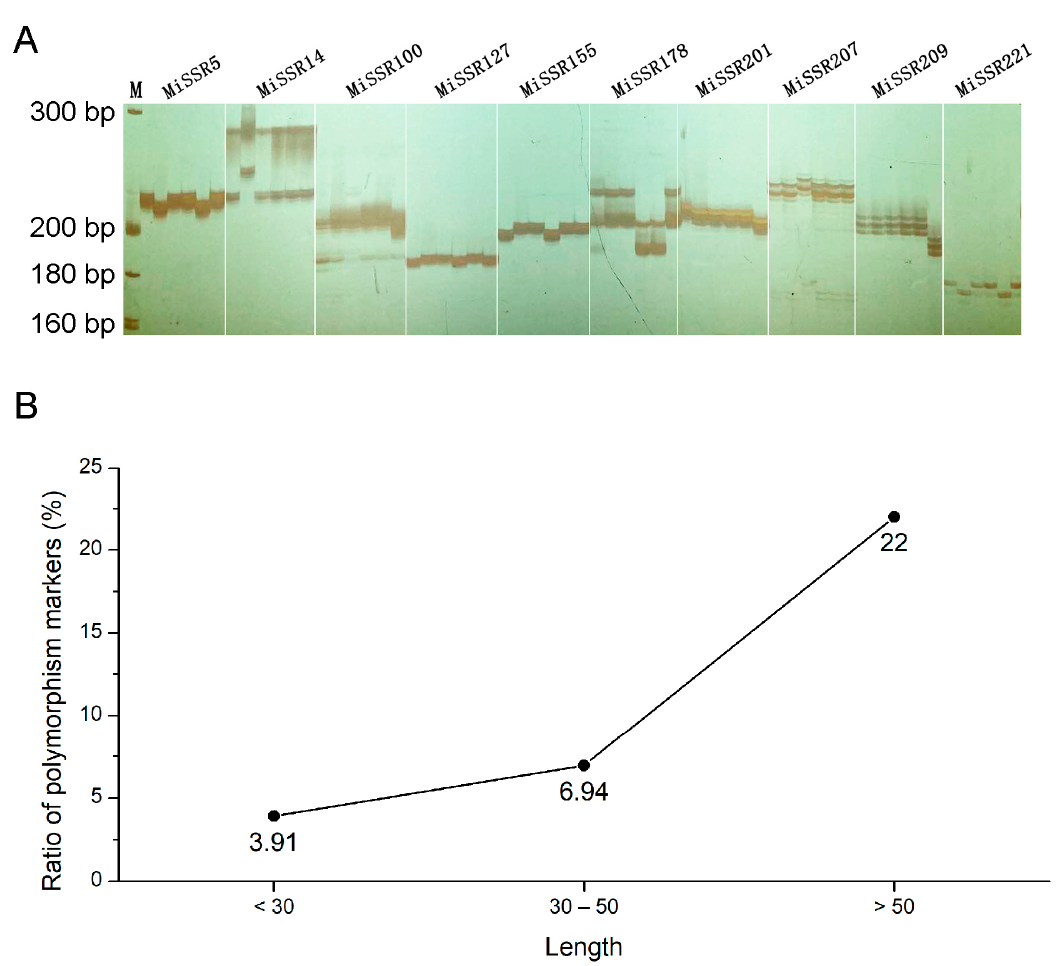
Figure 4. PCR verifies polymorphic markers. ( A ) The electrophoresis results of partial polymorphism markers in the six stock cultivars; M represents the DNA marker. ( B ) The ratio of polymorphic markers in SSR repeat motifs with different length.